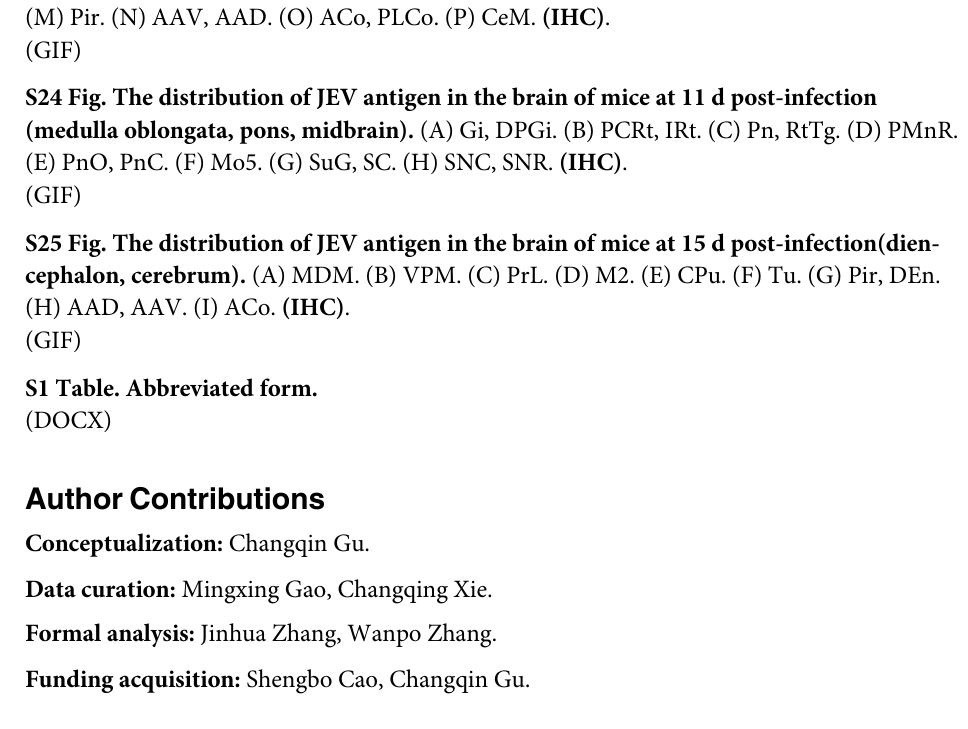
S20 Fig. The distribution of JEV antigen in the brain of mice at 6 d post-infection(medulla oblongata, pons, midbrain). (A) Gi. (B) MdV. (C) PCRt, IRt. (D) PMnR. (E) PnO, PnC. (F) Mo5. (G) DMPAG. (H) DpMe. (I) SNC, SNR. (IHC) . S21 Fig. The distribution of JEV antigen in the brain of mice at 8 d post-infection(dien- cephalon, cerebrum). (A) MDM, CM. (B) CL, MDL. (C) VL, VM, VPM. (D) PrL, MO. (E) LSD, LSI. (F) MM, ML. (G) CA1. (H) CA2. (I) M2. (J) M1. (K) AOP. (L) AOP. (M) CPu. (N) MePD, MePV. (O) ACo. (P) CeL, CeM. (IHC) . S22 Fig. The distribution of JEV antigen in the brain of mice at 8 d post-infection(medulla oblongata, pons, midbrain). (A) Gi, DPGi. (B) PMn. (C) PMnR. (D) Pn, RtTg. (E) PnO, PnC. (F) Mo5. (G) InWh, DpWh. (H) DpMe. (I) SNC, SNR. (IHC) . S23 Fig. The distribution of JEV antigen in the brain of mice at 11 d post-infection(dien- cephalon, cerebrum). (A) MDM, CM. (B) MDL, PC. (C) VL, VM, VPM. (D) Rt, VPL. (E) PrL, MO. (F) CA1. (G) CA2. (H) M2. (I) M1. (J) MM, ML. (K) CPu. (L) AOM, AOV, AOP. (M) Pir. (N) AAV, AAD. (O) ACo, PLCo. (P) CeM. (IHC) . S24 Fig. The distribution of JEV antigen in the brain of mice at 11 d post-infection (medulla oblongata, pons, midbrain). (A) Gi, DPGi. (B) PCRt, IRt. (C) Pn, RtTg. (D) PMnR. (E) PnO, PnC. (F) Mo5. (G) SuG, SC. (H) SNC, SNR. (IHC) . S25 Fig. The distribution of JEV antigen in the brain of mice at 15 d post-infection(dien- cephalon, cerebrum). (A) MDM. (B) VPM. (C) PrL. (D) M2. (E) CPu. (F) Tu. (G) Pir, DEn. (H) AAD, AAV. (I) ACo. (IHC) . (GIF) S1 Table. Abbreviated